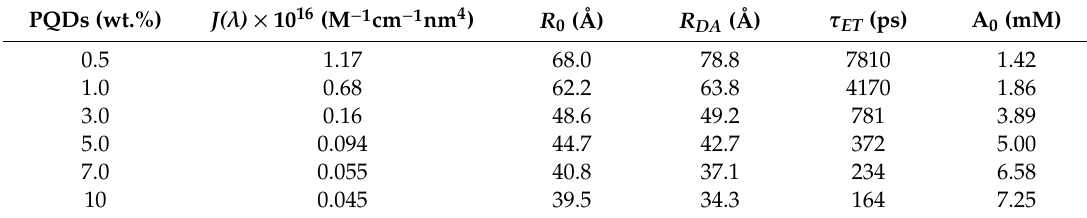
Table 3. Parameters of energy transfer from PFO to the PQD hybrid thin films in the presence of a fixed Figure 7. Stern–Volmer plot for the emission quenching of PFO with various PQD contents. amount of MEH-PPV. PQDs